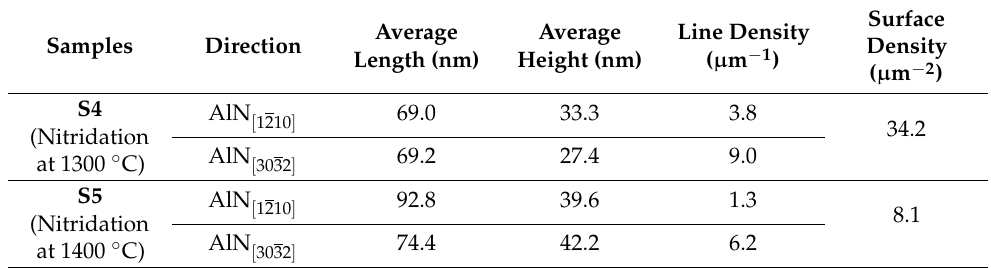
Figure 3. Cross-sectional scanning electron microscope (SEM) images taken along AlN [ Cross-sectional transmission electron microscope (TEM) images taken along AlN [ ( e ) Enlarged view of the distorted area marked by the dashed rectangle in ( d ). Table 2. Summary on the size and density of nano-holes at the interface between sapphire and AlN